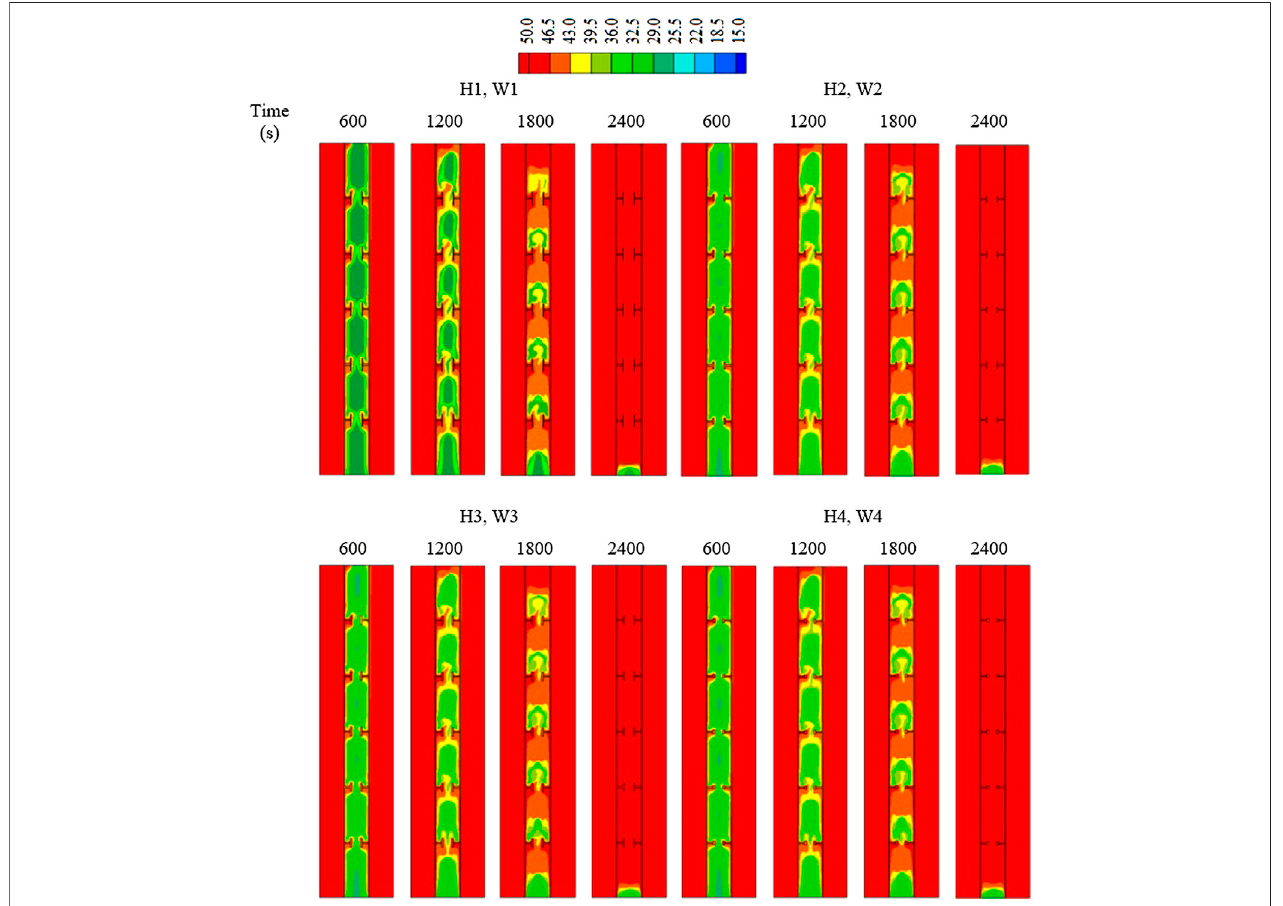
FIGURE 5 | The temperature distribution for various dimensions of the T-shaped fi ns heads at various times (the sizes of the fi n ’ s body are the same).